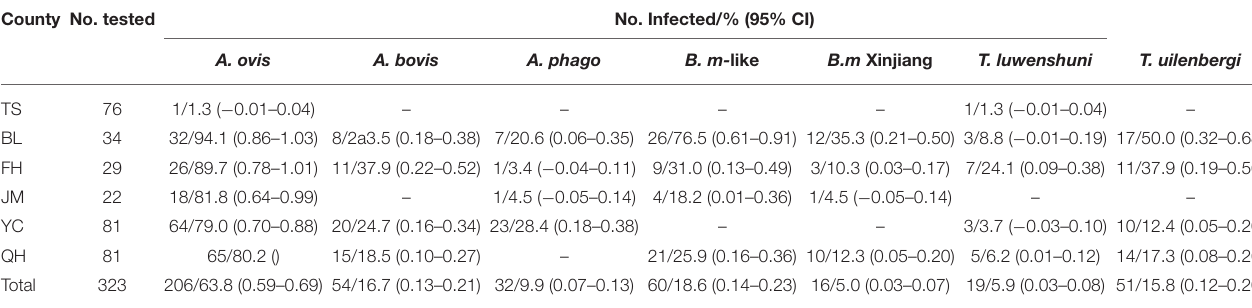
TABLE 1 | Detection of Anaplasma spp., Babesia spp., and Theileria spp. in sheep from XUAR, China. County No.